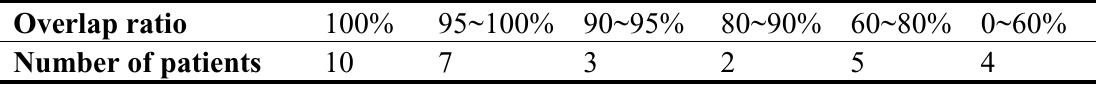
Table 3. Distribution of overlap